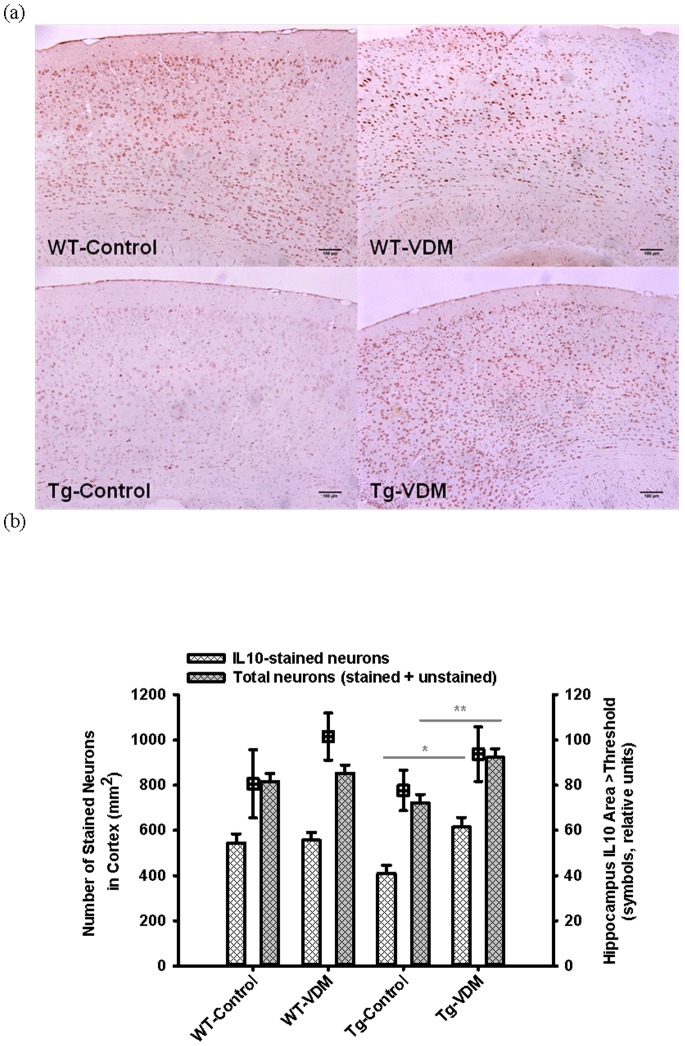
Immuno-histochemical quantification of IL-10-stained brain areas at 9 months.Typical images of IL-10-stained brains comparing mouse study groups (a) and results of quantitation by image analysis for the total cortex (neocortex plus temporal cortex, bars) and hippocampus (symbols) regions (b). Two way ANOVA analysis indicated significant effects of feed type (P<0.05) and interaction between genotype and feed type (P<0.05), with post-hoc feed type effect (Tukey test) significant for transgenic (IL-10- neuron area, P<0.001; total neuron number, P<0.05) but not wild type mice.